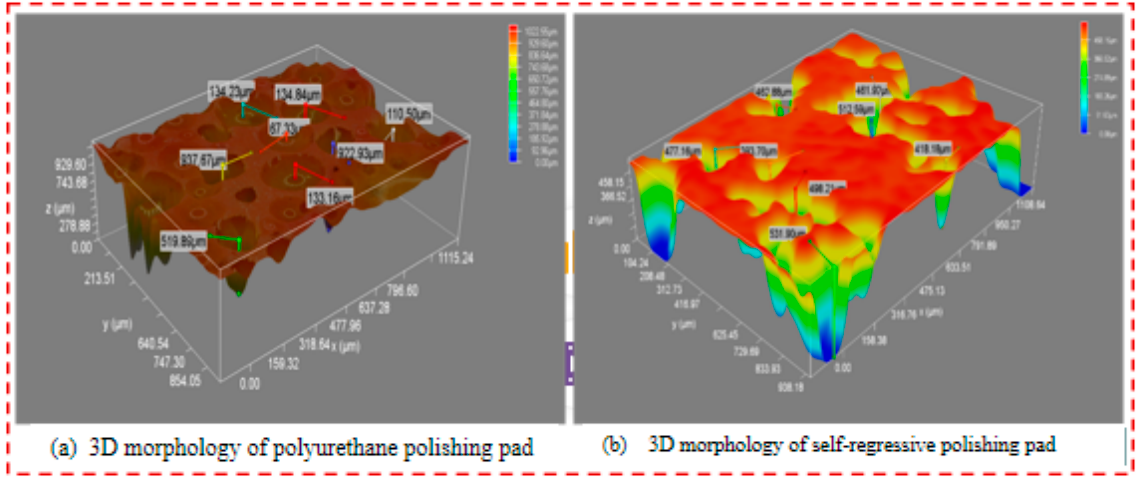
Figure 7. The deep morphology of the polishing pads’ holes. (a) 3D morphology of polyurethane polishing pad; (b) 3D morphology of self-regressive polishing pad Table 1. Comparison of the physical and mechanical properties of the different polishing pads.